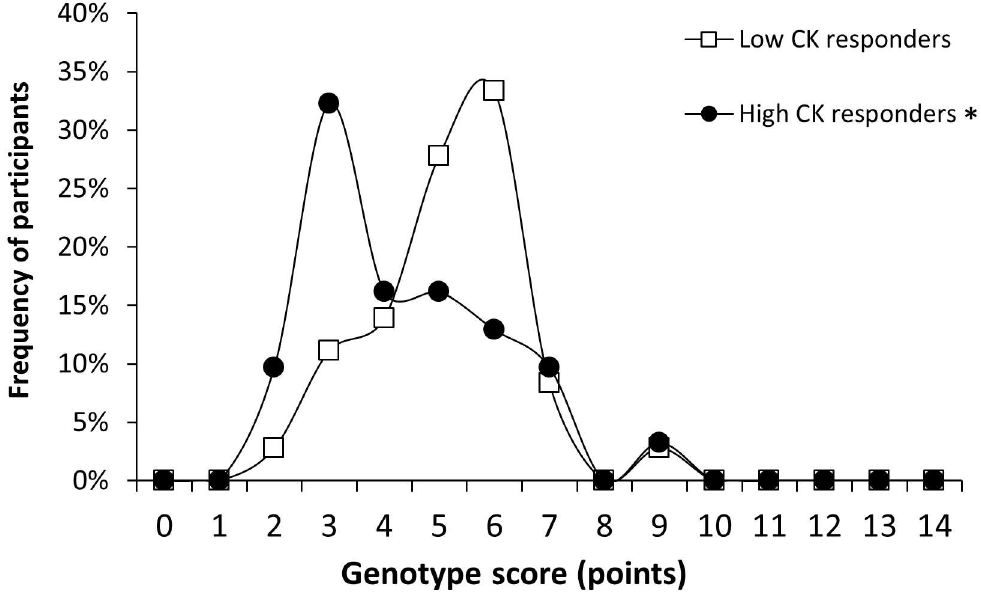
Fig 2. Frequency distribution of genotype scores (0–14 point) in low and high CK responders during a marathon competition. ( * ) Different from low CK respondersat P <